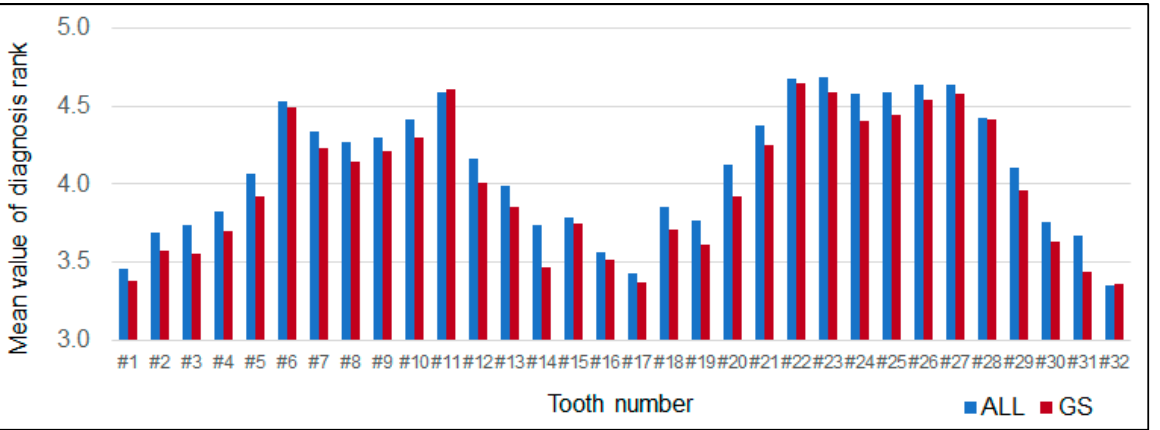
Figure 4. Comparison of the mean value of the diagnosis rank on each tooth between the learning data and gold standard rank (GS). The mean value of the learning data (4.19 ± 0.93) was significantly higher than the GS (4.07 ± 0.98, p < 0.0001, unpaired t test).